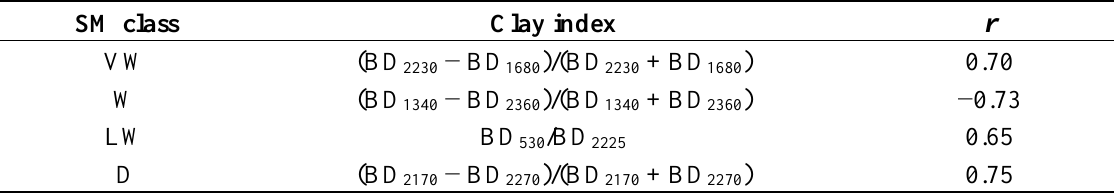
Figure 4. Pearson’s correlation coefficient between clay content and band depth spectral values for the four soil moisture classes of the MAC dataset (VW: very wet; W: wet; LW: low wet; D: dry). Table 4. Band Depth (BD) clay indices for classes having different soil moisture (SM) level (D = dry, LW = little wet; W = wet, VW = very wet) and Pearson’s correlation coefficient ( r ) between indices and clay